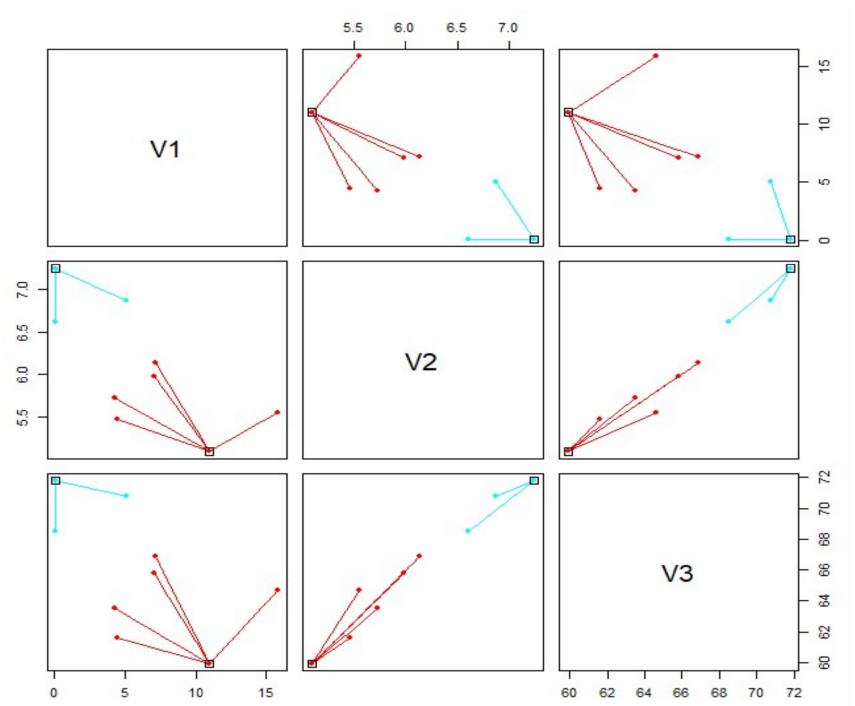
Figure 5. Clustering result for two-response combinations (two-cluster scheme) of the three water quality indices (V1 = removed Na + , V2 = SAR, V3 = Na +